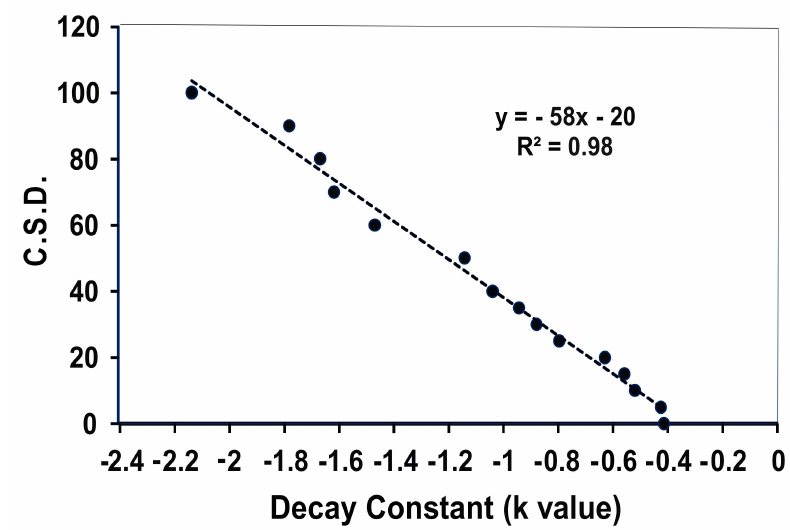
Figure 3. Standard curve inter-relating decay constant (k) with circular standard deviation (c.s.d.). This graph was generated using the computer-simulation procedures of Figure 2 and a run time of 400 steps. Ten replicate runs generated 10 k values for each c.s.d. S.E.M. values around the mean e-values were too small to be visible.